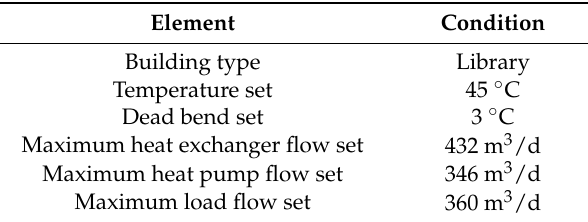
Table 5. Experiment condition.